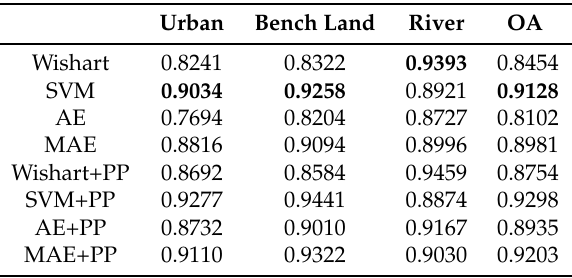
Table 8. The correct rate of each category and overall accuracy for the four comparison methods and those of the corresponding PP steps for Xi’an area